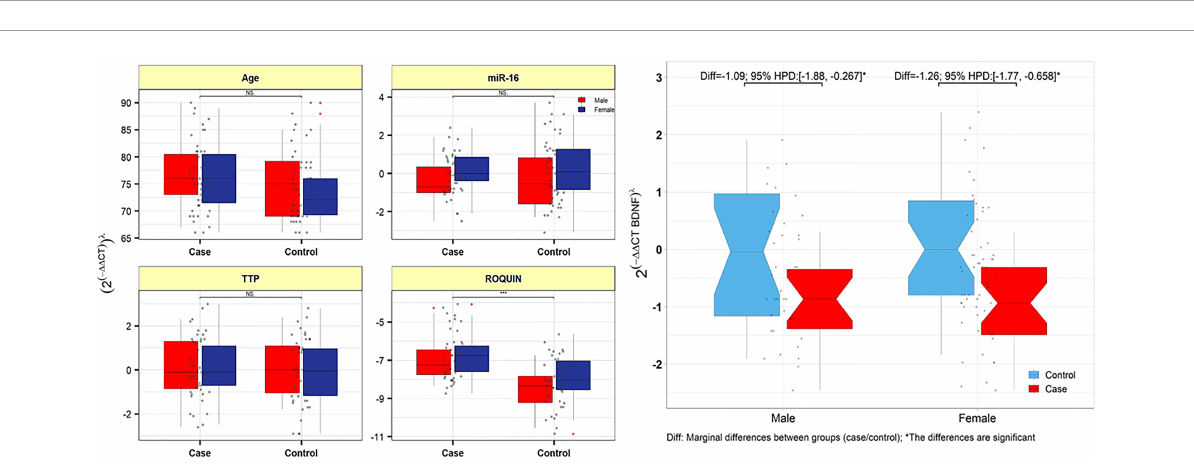
FIGURE5 TTP, ROQUIN, hsa-miR-16-5p, and BDNF expression in peripheral blood samples from patients and controls. Gray dots show values. The means of expression levels and the interquartile range are